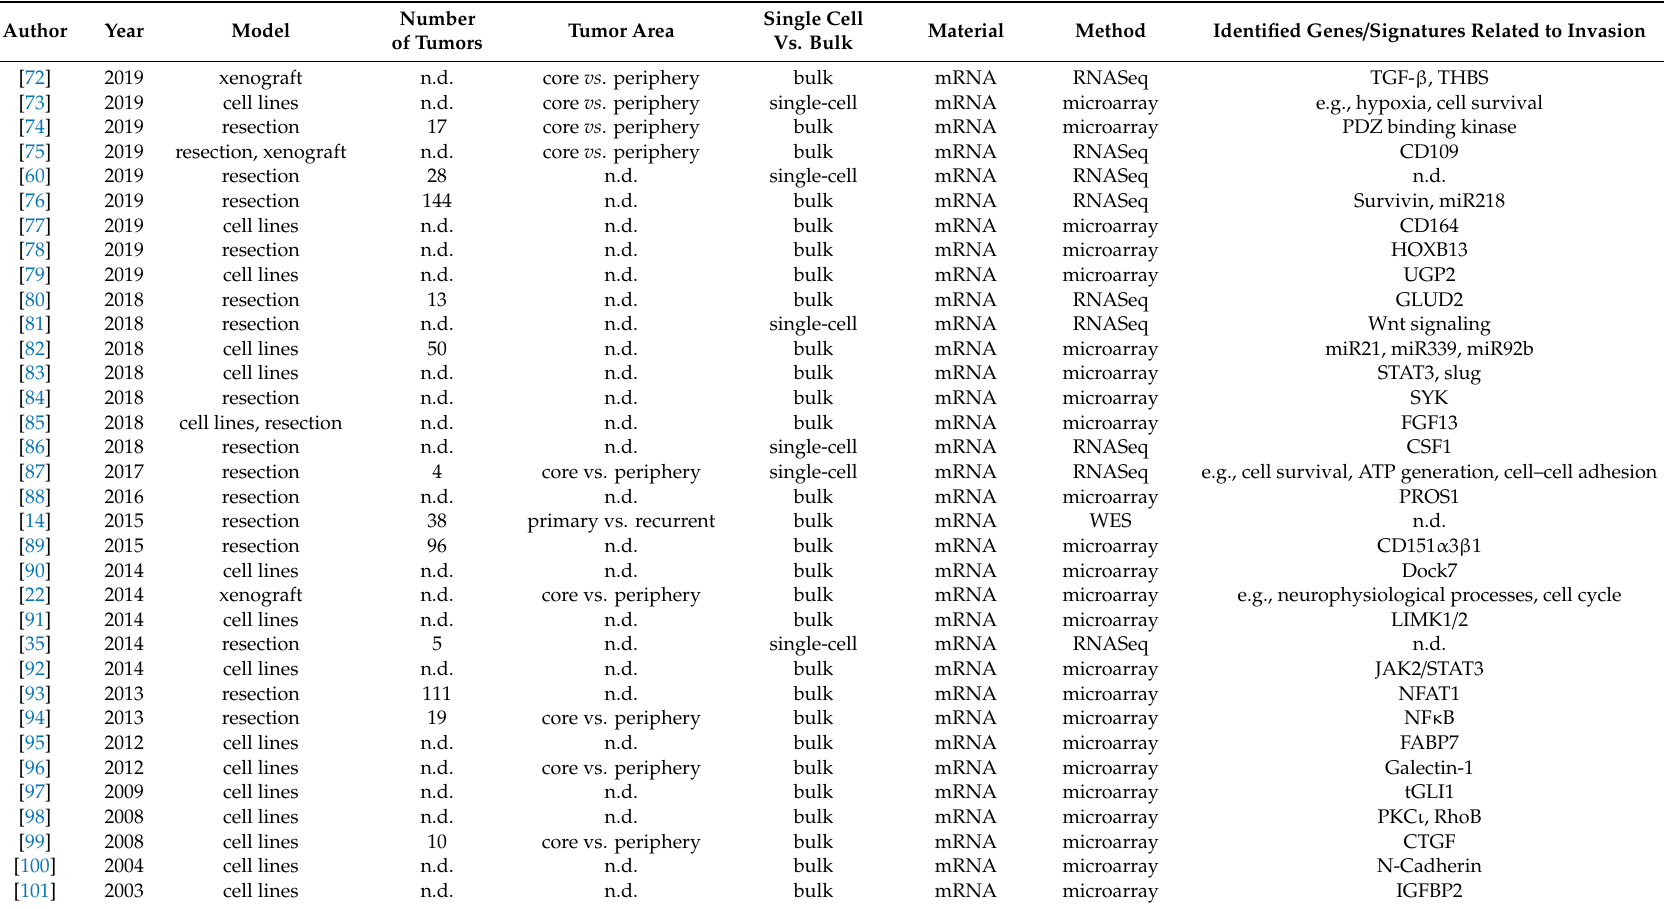
Table 1. Publications with a focus on glioma cell invasion using bulk and single cell analysis. If not otherwise stated, human tumor material was used. Tumors were harvested from the tumor core, the tumor periphery, or without a specific allocation. Single cells or cells from the tumor bulk were harvested and used for further analysis. RNASeq, RNA-Sequencing; N.d., not